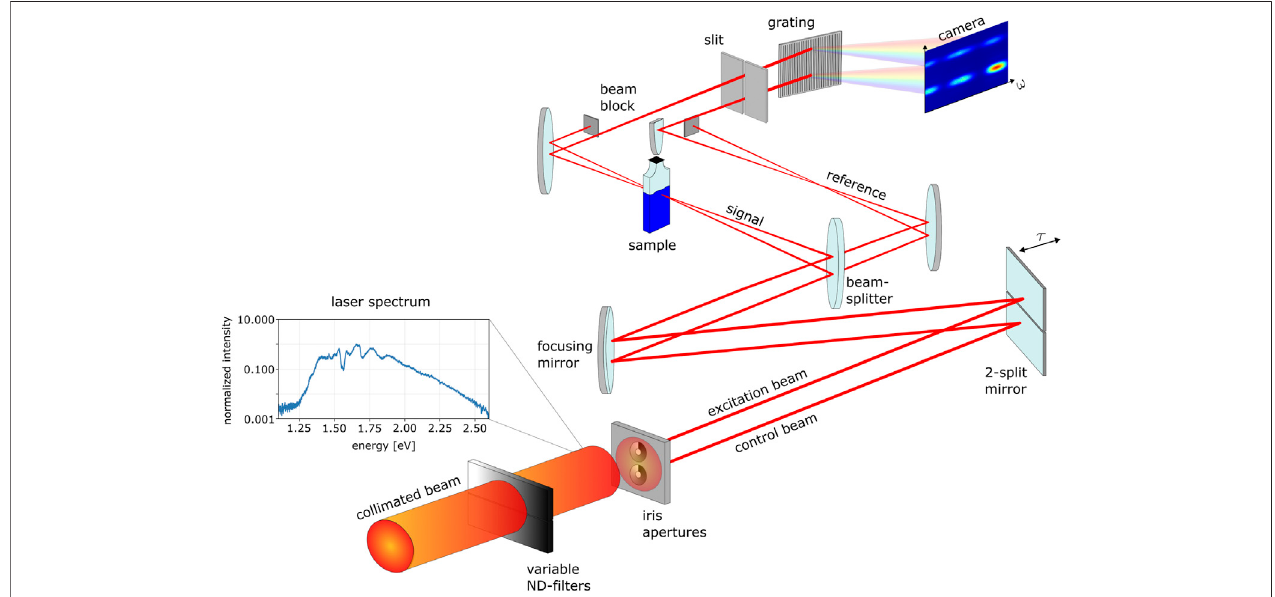
FIGURE4| Experimentalresponse-controlsetup.Seetextfordetails. — Note:The2-splitmirror,aswellasthefocusingmirrorareexperimentallyhitunderclose-to- normal angle of incidence. Increased angles are depicted in the illustration for a better schematic overview of the experimental setup.